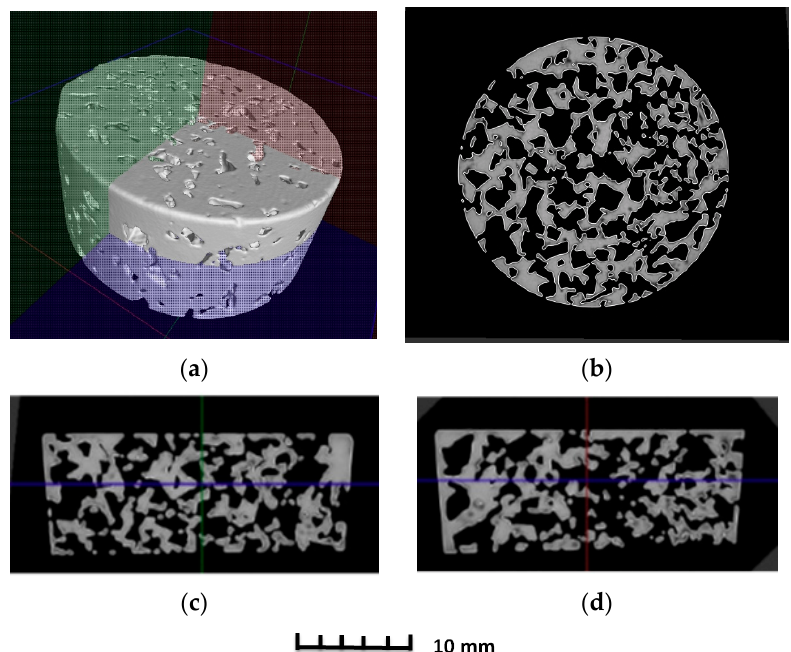
Figure 23. Demonstration of porosity in selected planes of aluminium porous material,.AlSi12 sample SAM6, evaluated on a METROTOM 1500 CT ZEISS industrial computed tomograph: diagram of planes of section through porous sample ( a ); cut plane—purple colour ( b ); cut plane—red colour ( c ); cut plane—green colour ( d ).